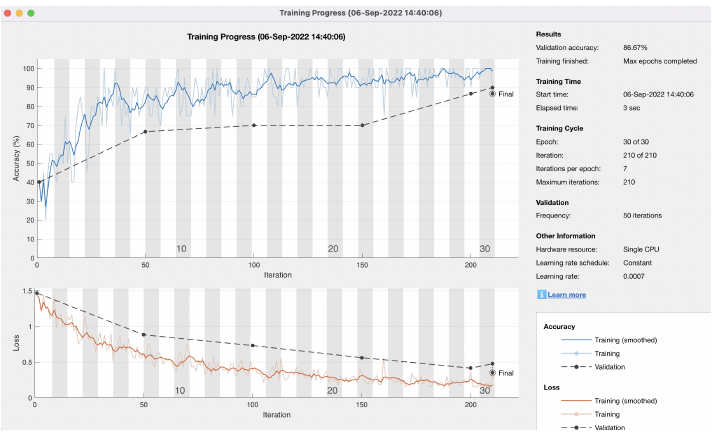
Figure 10. This figure shows the trend of the training progress in the case of a subarea in which the lambda value is equal to